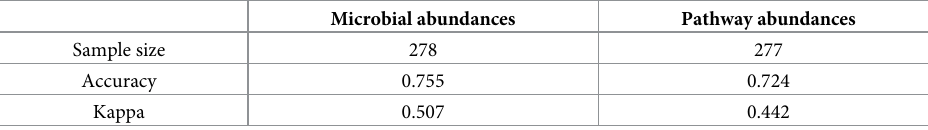
Table 2. Performance of random forest on microbial and pathway